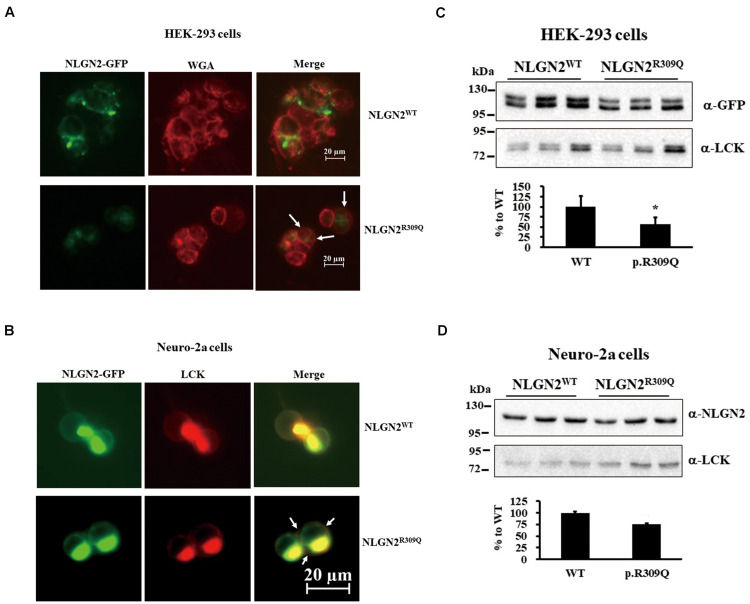
NLGN2-GFP fusion protein expression was reduced in the membrane fraction of cultured cells carrying NLGN2R309Q mutant compared with the WT construct. (A) Subcellular localization of NLGN2 fusion GFP protein in HEK-293 cells transiently cotransfected either with NLGN2WT or NLGN2R309Q plasmids. WT proteins colocalized to the membrane in transfected HEK-293 cells, whereas NLGN2R309Q mutant proteins colocalized to the membrane (WGA) at a lower level (arrow). (B) Subcellular localization of NLGN2 fusion GFP protein in neuro-2a cells transiently cotransfected either with NLGN2WT or NLGN2R309Q plasmids and LCK plasmids. WT proteins colocalized to the plasma membrane marker (LCK) in transfected neuro-2a cells, whereas NLGN2R309Q mutant proteins colocalized to LCK at a lower level (arrow). (C) Immunoblotting of protein extracts from the membrane fraction of HEK-293 overexpressed either with NLGN2WT or NLGN2R309Q plasmid. (D) Immunoblotting of protein extracts from the membrane fraction of neuro-2a cells overexpressed either with NLGN2WT or NLGN2R309Q plasmid. WT, wild-type. WGA and LCK, membrane protein markers wheat germ agglutinin and lymphocyte-specific protein tyrosine kinase, respectively. Graphs represent means ± standard errors. *p < 0.05.